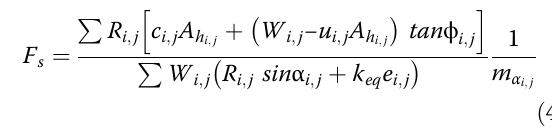
from the rotation axis to the geometric center of the poten- tial sliding face of column i,j , e i,j is the horizontal driving force moment arm, α i,j is the apparent dip angle and k eq is the horizontal pseudo-acceleration coefficient. The factor of safety expressed in Eq. 3 is suitable for all general moment equilibrium method, and the normal force can be further obtained by the force equilibrium in vertical and horizontal directions in Bishop ’ s simplified method. Then by substitut- ing the calculated normal force from the force equilibrium into Eq. 3, the factor of safety is finalized as Eq. 4.